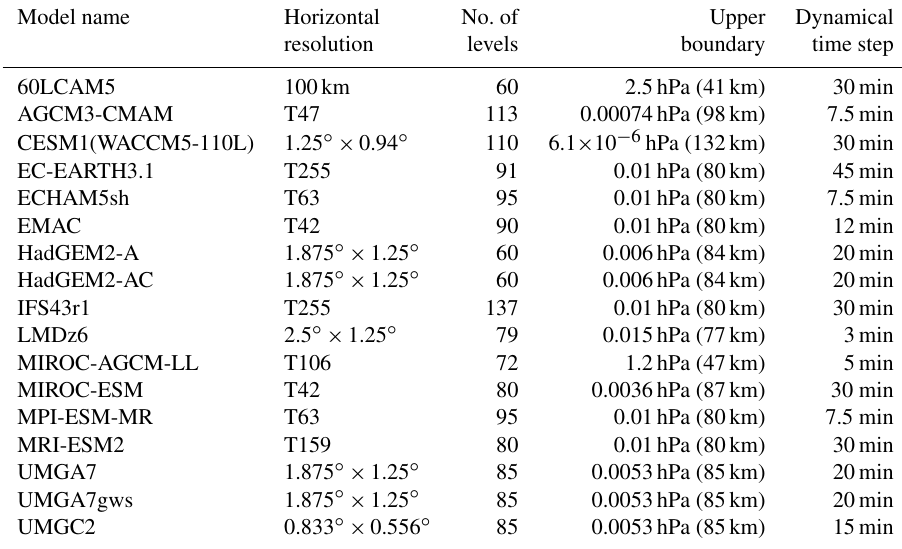
Table 6. Model domain and resolution.